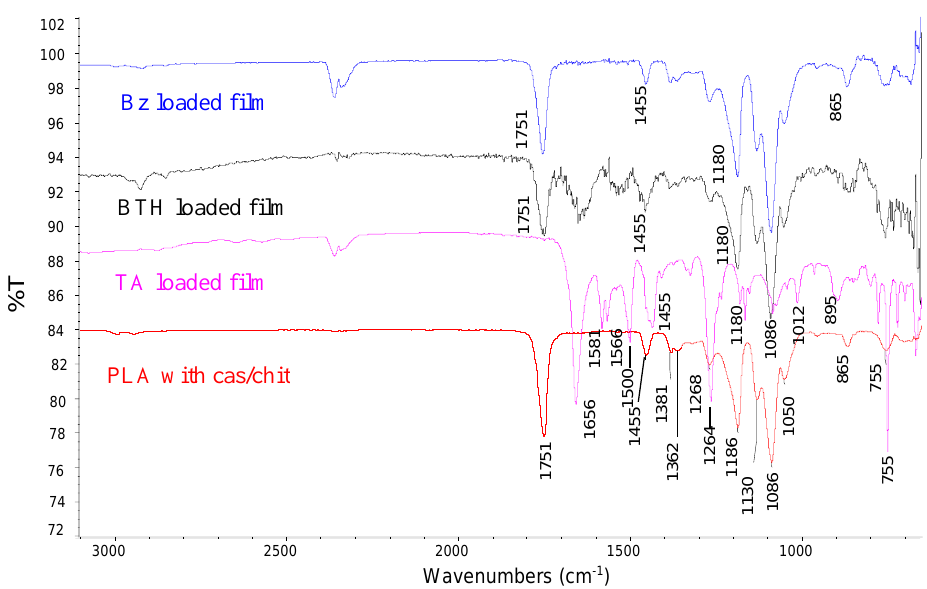
Figure 3. ATR-FTIR spectra of casein-chitosan polyelectrolyte multilayer films. AFM was used to investigate the multilayer films’ surface morphology. AFM image of MLF-PL (Figure 4) indicates that the film is characterized with uniform surface morphology and lower surface roughness- Rq = (5.125 ± 0.63) nm. The size of the morphological units is about 500 nm in diameter. The densely packed structure for films implies a good entrapment efficiency of drugs, suggesting capacity for prolonged release [29].